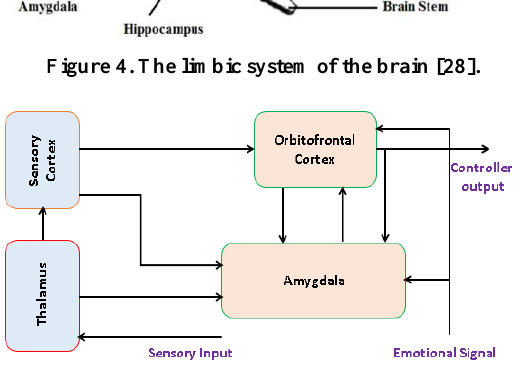
Figure 6. Graphical depiction of the BEL process